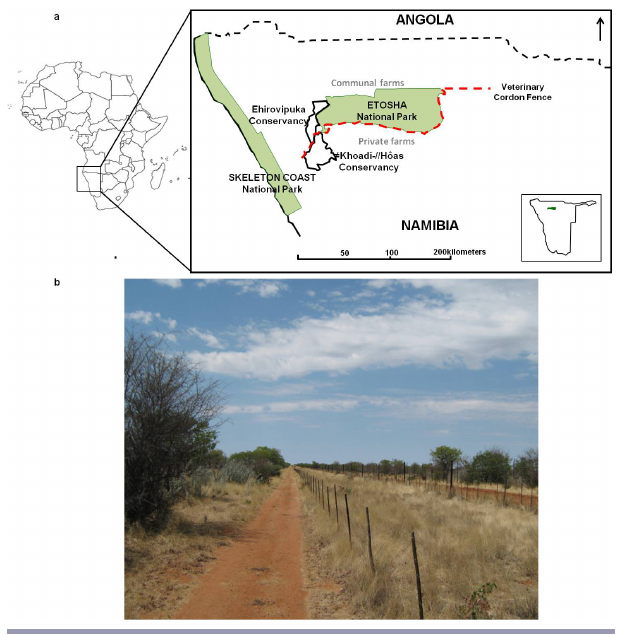
Fig. 1 . Map of the study area in northwestern Namibia, including the Etosha National Park (ENO), private, and communal farms (a). The veterinary cordon fence or “red line” (dashed line) divides adjacent rangelands in the study area from the ENP and is a double fence (b), consisting of a high game- proof fence (right) separated by a 10-m passage from a stock- proof fence on the side of the farms and communities